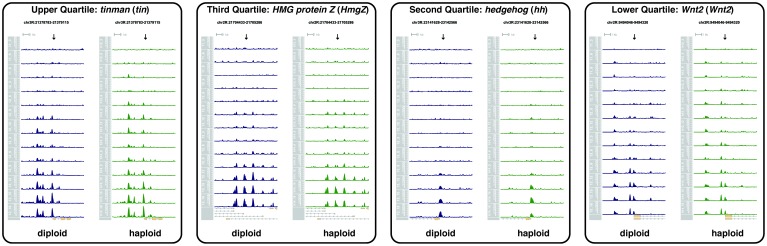
Examples of N:C-ratio-dependent regions.Each plot shows the accessibility profiles over time for diploid (left, blue, NC11 to NC13) and haploid (right, green, NC12 to NC14) samples at four regions selected on the basis of the distribution of open ATAC-seq coverage within the total set of N:C-ratio-dependent peaks. The y-axis shows coverage of open ATAC-seq reads at an equal scale for all eight plots. The x-axis shows a 10 kb region centered over the peak region of interest (arrow, coordinates provided at top of plots). The gene models mapping to the displayed region are shown at bottom (yellow). An N:C-ratio-dependent region is expected to gain accessibility at equivalent nucleo-cytoplasmic ratios, not equivalent nuclear cycles. The timecourses for diploid and haploid samples are aligned by equivalent nucleo-cytoplasmic ratios. As such, it is expected that N:C-ratio-dependent peaks show equivalent accessibility horizontally across the plots. Certain loci (e.g., tinman) gain accessibility one timepoint earlier in haploids than diploids. Our analysis was not designed to distinguish single-timepoint shifts in the onset of accessibility. Rather, our analysis focused on changes in accessibility from samples pooled by entire nuclear cycles/N:C ratios.